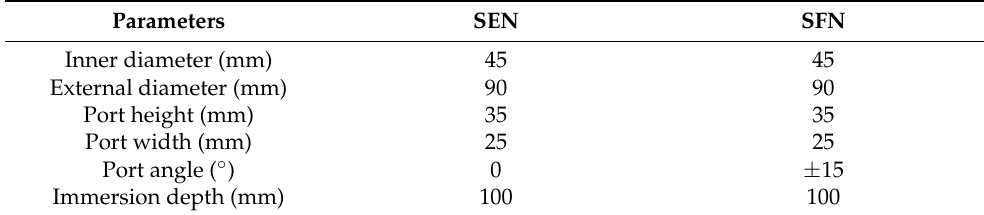
Table 1. Geometric dimensions of the three kinds of nozzles.